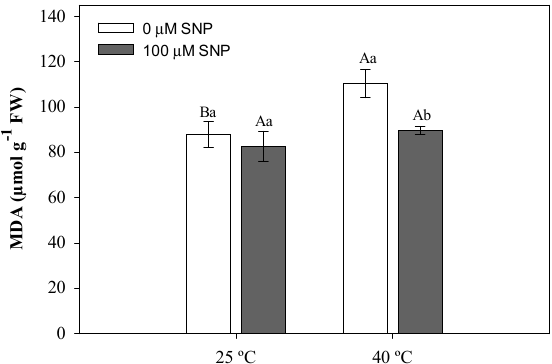
Figure 6. Malondialdehyde (MDA) concentration in soybean plants submitted to two temperatures (25 ◦ C and 40 ◦ C) and two SNP concentrations (0 and 100 µ M). Bars represent means ( n = 5) ± SE. Capital letters (between temperatures) and lowercase letters (within temperatures) represent significant differences using Tukey’s test ( p < 0.05).